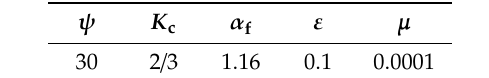
Figure 13. Comparison of failure modes. Table 6. Grout parameters